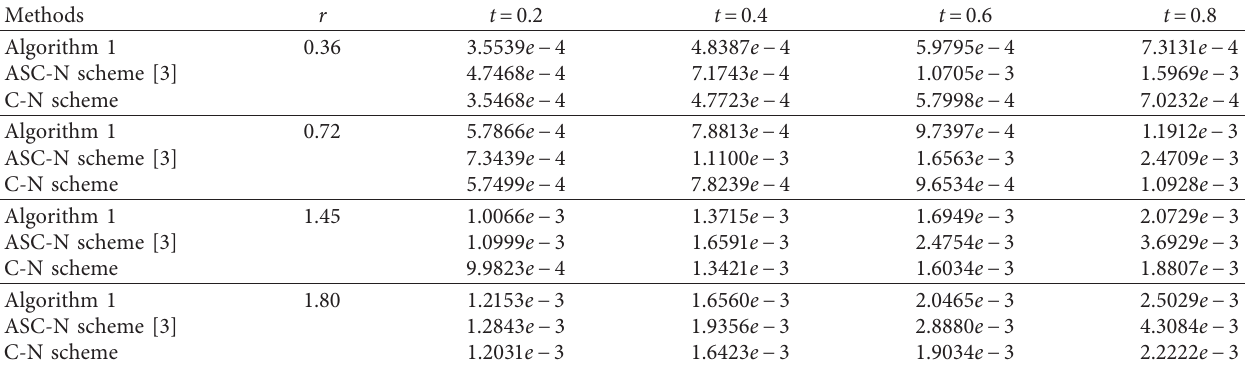
Table 4: Comparisons by the maximum errors to Example 1 for h � 1/19 (i.e., K � 3).